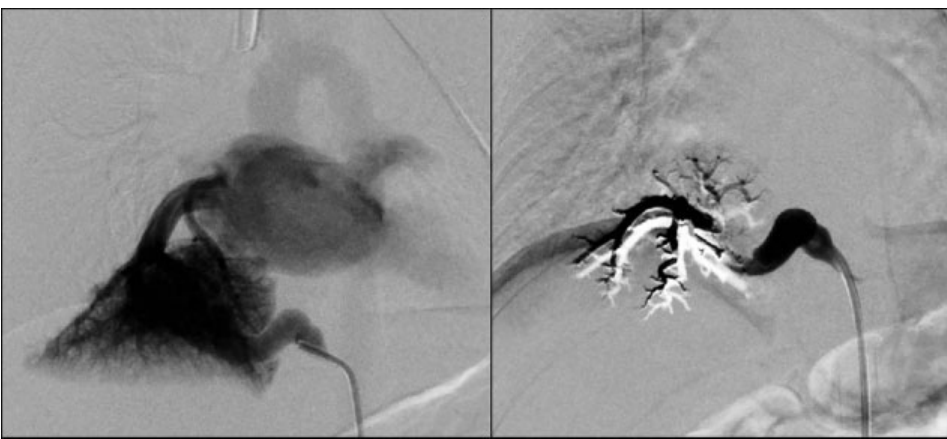
Fig. 2 Pre- and postembolization angiogram demonstrating cessation of fl ow through the pulmonary